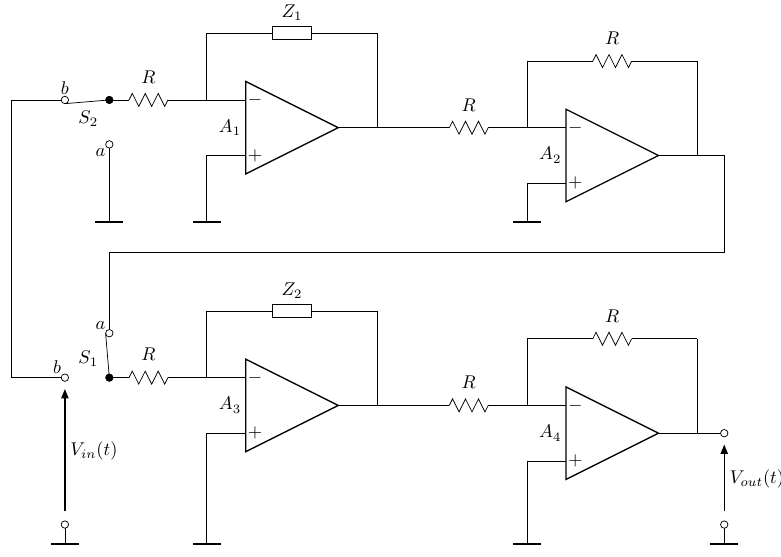
Figure 3. Analog model of D fractional variable-type and order